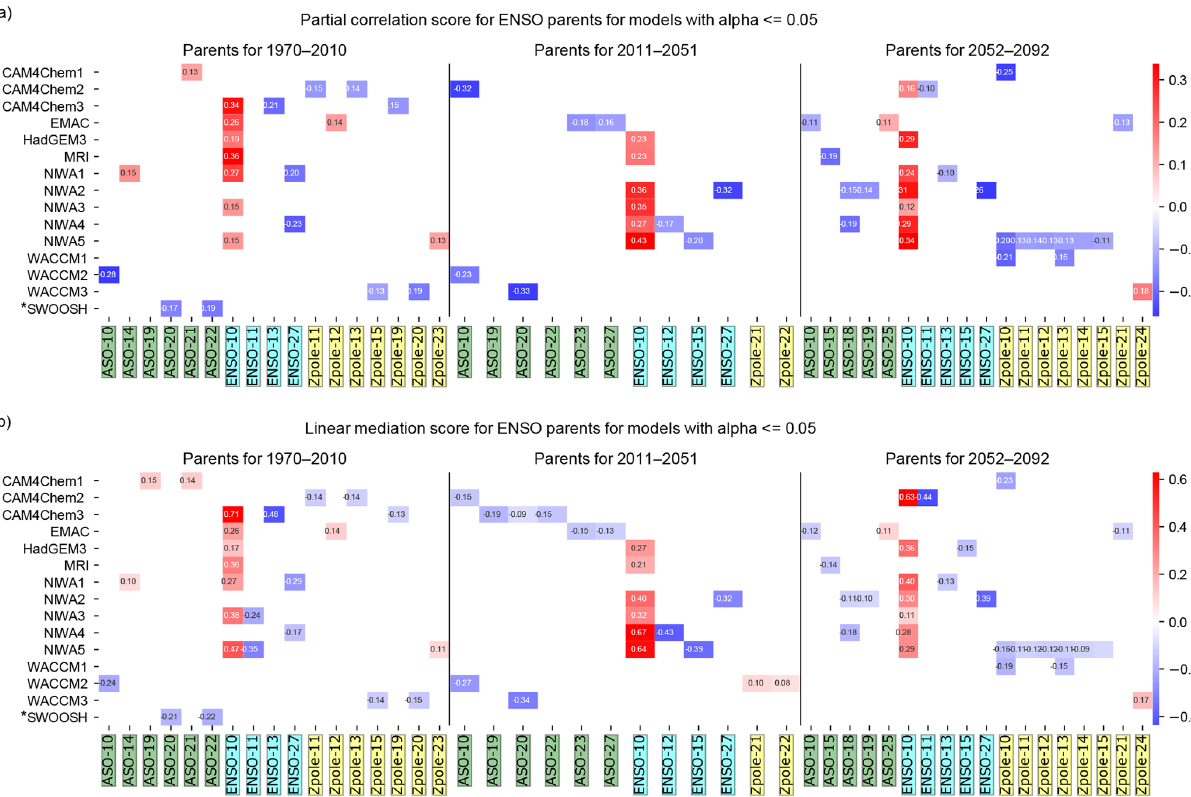
Figure 11. Pearl causality analysis of the parents of ENSO using the (a) PCMCI algorithm and (b) using the PC algorithm with linear mediation. See Sect. 2.2 for details of the algorithm. Observations are in the bottom row, and each of the CCMI models is shown separately. Parents of ENSO are shown in color, with darker shades for more robust